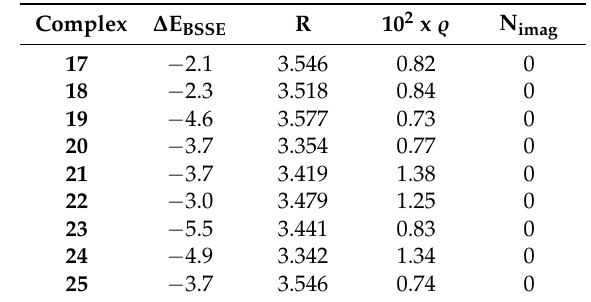
Table 1. Interaction energies with basis set superposition error (BSSE) correction ( Δ E BSSE in kcal/mol), equilibrium distances (R, Å), value of the density at the bond critical point (CP) (10 2 x ρ , a.u.) and number of imaginary frequencies (N imag ) for complexes 17 – 32 at the RI-MP2/def2-TZVPD level of theory.